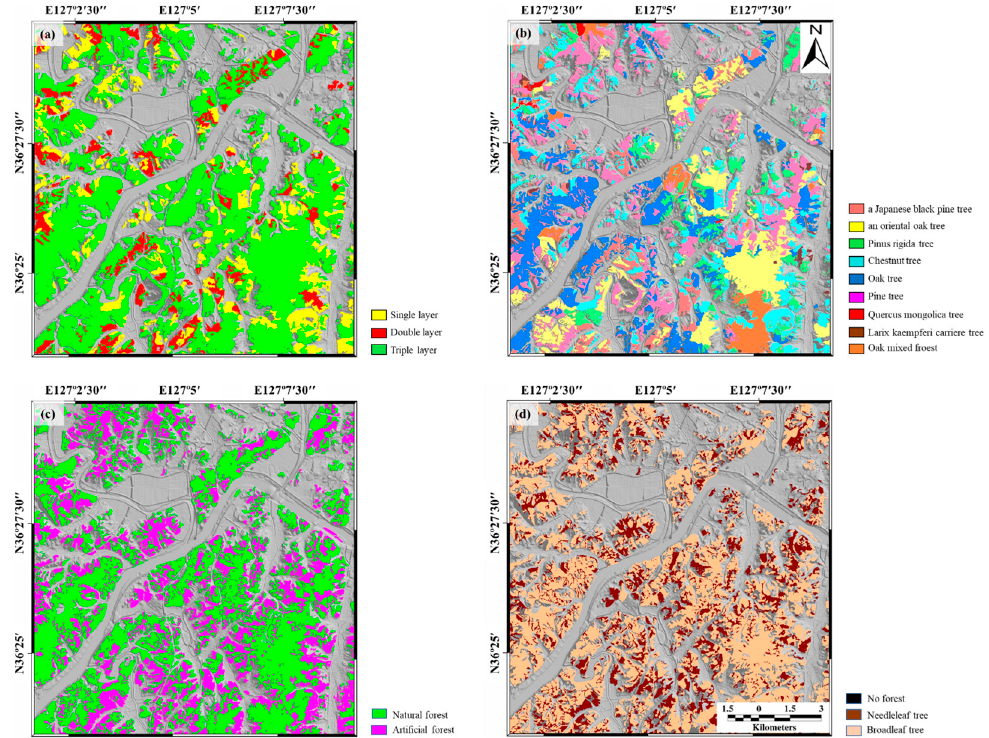
Figure 2. Forest vertical structure classification map of study area constructed by the field survey: ( a ) Forest vertical structure, ( b ) dominant species, ( c ) natural and artificial forests, and ( d ) dominant species’ leaf type [35] .